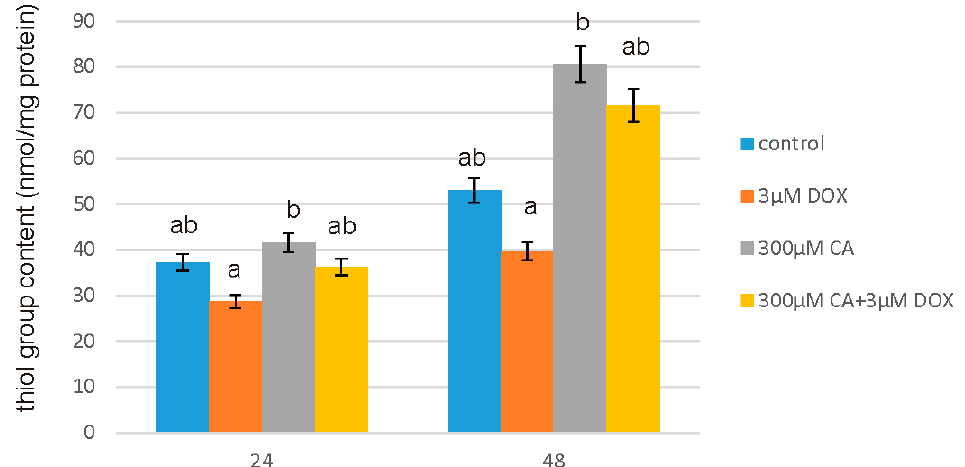
Figure 6. The effect of DOX, CA and CA+DOX on SH group content in fibroblasts. The cells were incubated with 3 µ M DOX, 300 µ M CA and DOX (3 µ M) combined with CA (300 µ M) for 24 h and 48 h Mean values from three independent experiments ± SD are shown. Different letters (a, b) indicate statistical differences ( p ≤ 0.05) between control, 3 µ M DOX, 300 µ M CA and DOX combined with CA estimated by Tukey’s test.